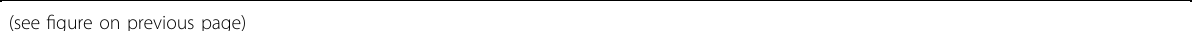
Fig. 2 MiR-98 packed into EVs can be transferred from neurons to microglia. a The procedure of primary neuronal-conditional media (NCM) collection and coculture with primary microglia. b Positive rate of Rat primary cortical neuron (MAP2) and microglia (IBA1). c The relative miR-98 expression level of microglia after added with NCM from starvation and OGD-R treatment and GW4869 blocking. ( n = 3 independent experiments). d The relative miR-98 expression level between neuron and microglia of puri fi cation culture, using the miR-98 expression of Neuro-2a (N2a) cells as a baseline. e The procedure of extraction of primary neuronal EVs and co-cultured with microglia. f Transmission electron micrograph (TEM) of neuronal EVs. g Size distribution of neuronal EVs based on Zetasizer Nano-ZS90 measurements. h Western blot for EVs markers Alix, TSG101, and Calnexin. i Representative images of internalization of PKH26-labeled neuronal EVs into the CellTracker TM Green-labeled microglia 12 h after coculture. j Relative miR-98 level in microglia 24 h after incubated with PBS and neuronal EVs (extraction by ~80~100 ml neuronal media). ( n = 5 independent experiments). Data are shown as means±S.E.M., * P , # P < 0.05; ** P < 0.01; *** P < 0.001 vs corresponding control. k – n Transmission electron micrograph (TEM) of serum EVs from both individuals and rats. o – p Size distribution of serum EVs from both individuals and rats. q Western blot for EVs markers Alix, TSG101, and GAPDH. r The relative miR-98 expression level between in serum EVs between both individuals and